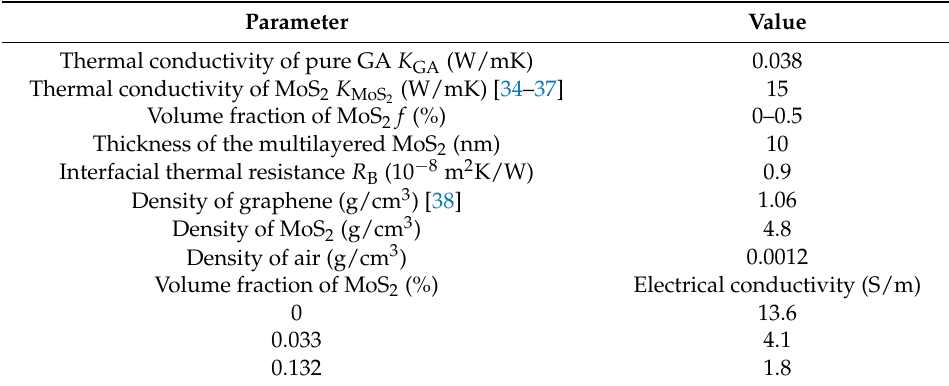
Table 1. Parameters used to predict the effective thermal conductivity of composite GA by using the EMT and the measured electrical conductivity of composite